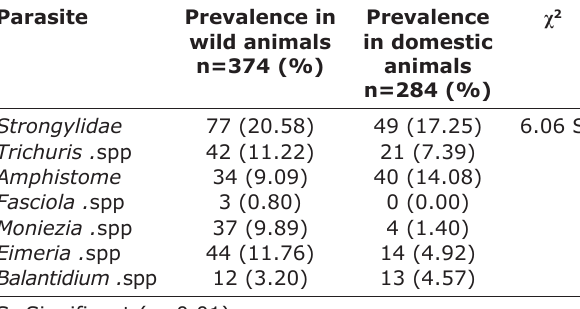
Table-1: Comparative prevalence of parasitic infection in wild and domestic